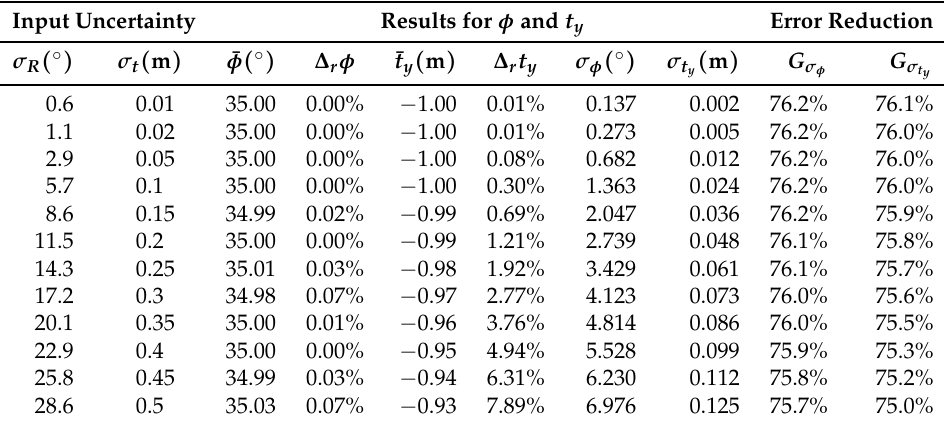
Table 6. Summary of uncertainty propagation when using five paths with uniform PDF for input uncertainties in the MCS analysis. The last columns in the table show the gains in error reduction by using the multi pairwise